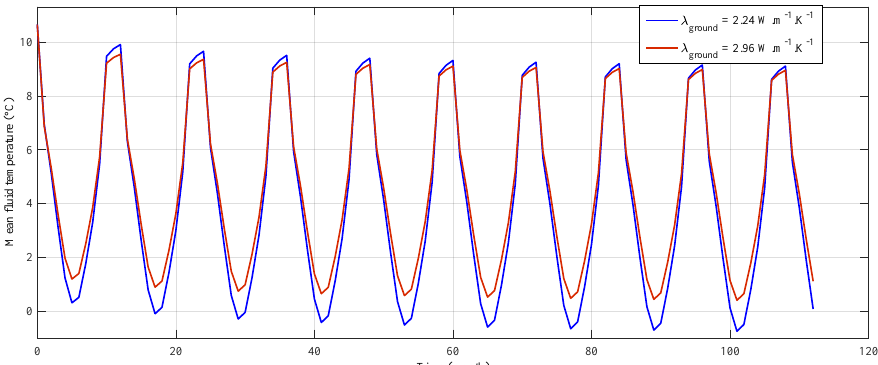
Figure 10. Mean of the fluid temperatures at the inlet and outlet of the BHE at the end of each month during the simulation period of 10 years. Each curve is representing a simulation at certain thermal conductivity of the ground while the other simulation parameters remain